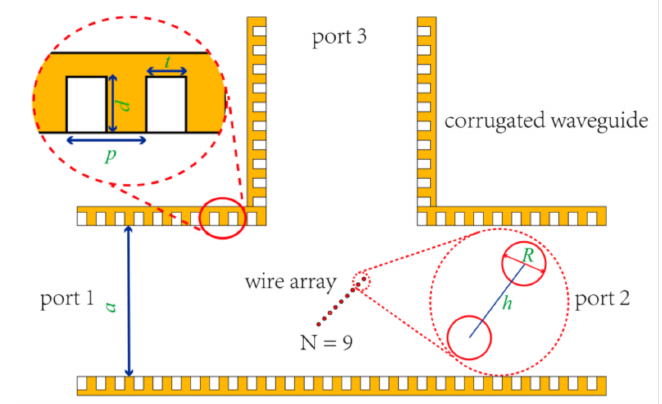
Figure 7. Sectional view of the three-port directional